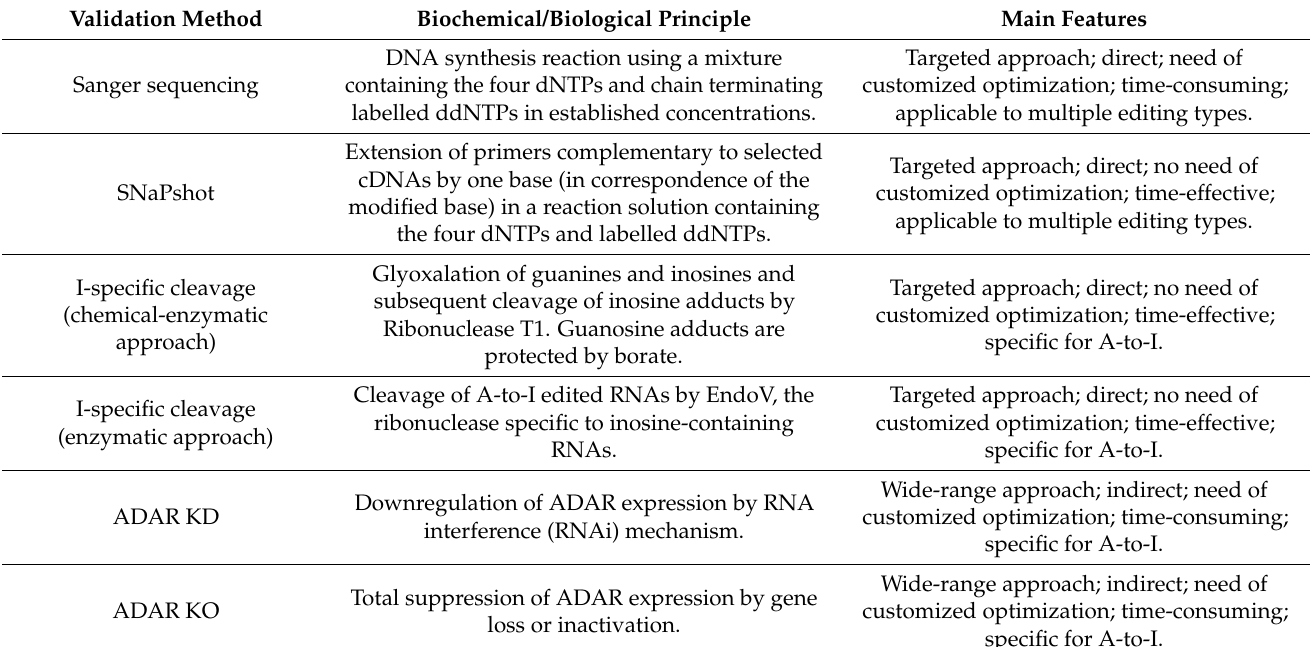
Table 1. Major characteristics of validation methods listed in this